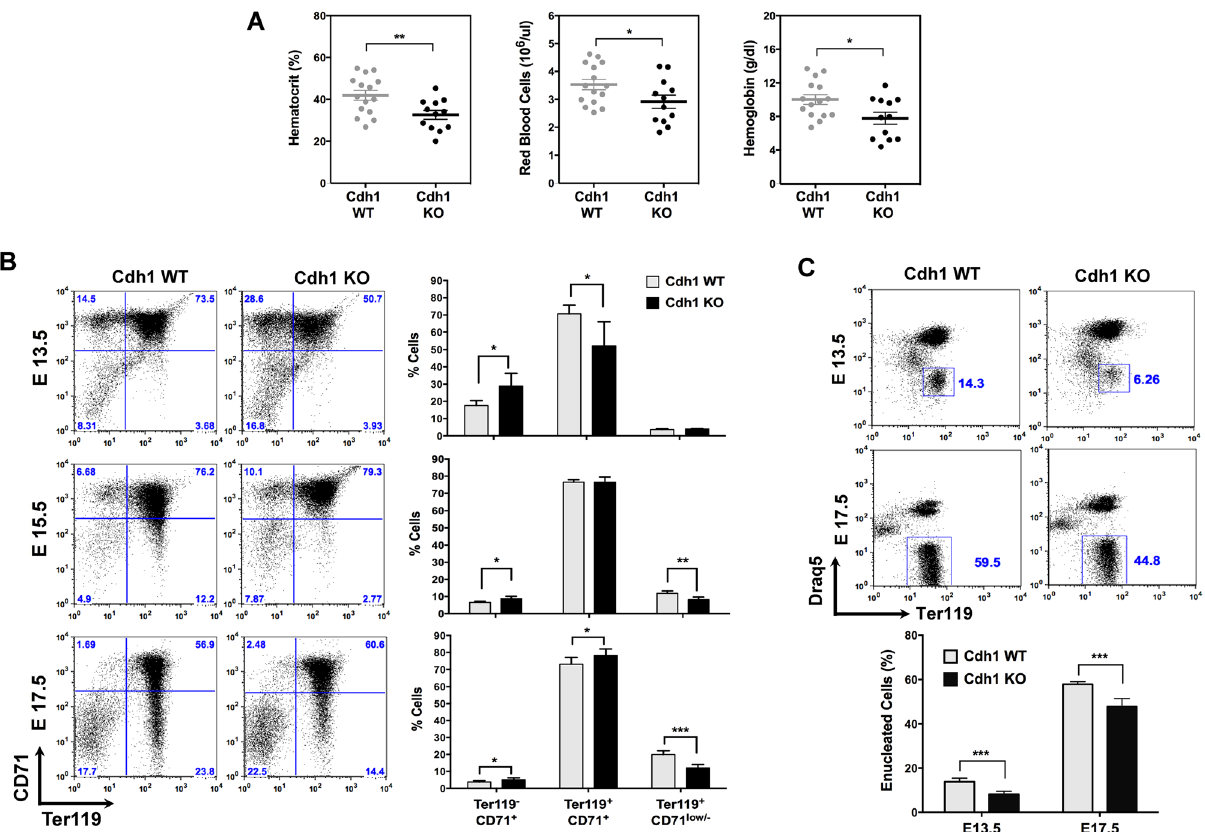
Figure 1. Cdh1 deficiency leads to inefficient fetal erythropoiesis and anemia at birth. ( A ) Red cell parameters from peripheral blood of control (Cdh1 WT) and Cdh1-deficient (Cdh1 KO) pups collected 12 to 18 h after birth. The scatter dot plots show mean ± s.e.m of the corresponding data (n = 15 for WT and 12 for KO). ( B ) Erythroid maturation was assessed based on expression of Ter119 and CD71 cell surface markers in fetal livers of the indicated embryonic stage and genotype. The ratios of pro-erythroblasts (Ter119 - CD71 + ), immature erythroblasts (Ter119 + CD71 + ), and mature erythroblasts and reticulocytes (Ter119 + CD71 low/- ) were determined in 4–7 samples for each stage and genotype (bar graphs, right). Representative flow cytometry plots are included on the left. ( C ) Quantification of the percentage of enucleated erythroid cells (Ter119 + Draq5 - ) in fetal livers from the indicated embryonic stage and genotype. The top panels show representative flow cytometry profiles. n = 10 for E13.5; n = 6 for E17.5; * P < 0.05, ** P < 0.01, *** P <